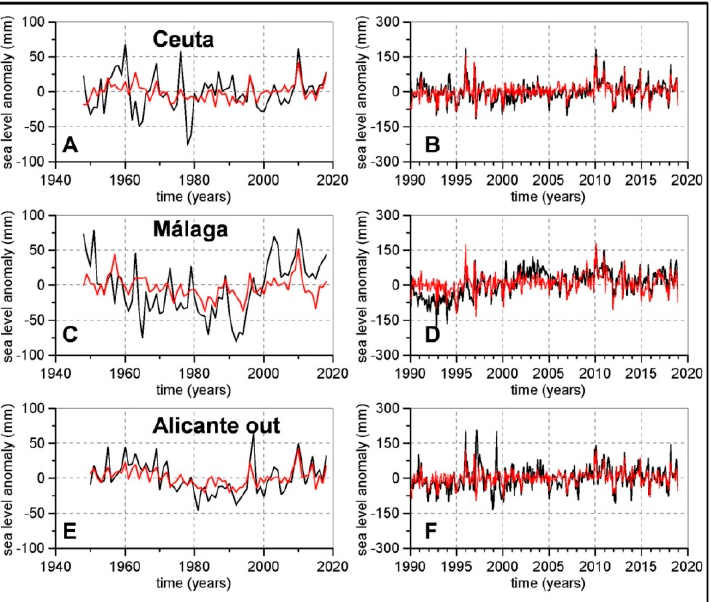
Figure 7. Observed sea level anomalies and regression from the linear model. Black lines are the observed sea level (de-seasoned and de-trended) at Ceuta, Málaga, and Alicante. Red lines are the values predicted by a linear model based on the atmospheric variables and the thermosteric and halosteric components of sea level (see the text and Table 4). ( A , C , E ) show annual mean values for the period 1948–2018. ( B , D , F ) show monthly values for the period 1990–2018.